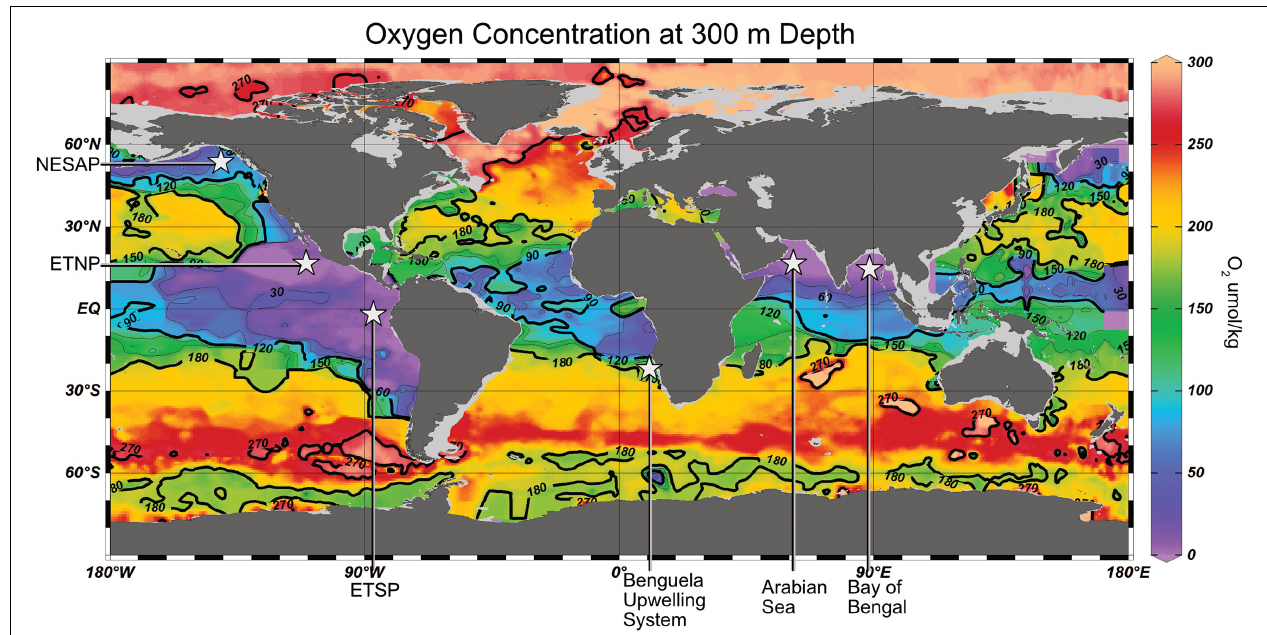
FIGURE 1 | Global map of oxygen concentrations at 300 m depth. Data from NOAA World Ocean Database using all O 2 data from 2009–2018. Data was plotted using Ocean Data